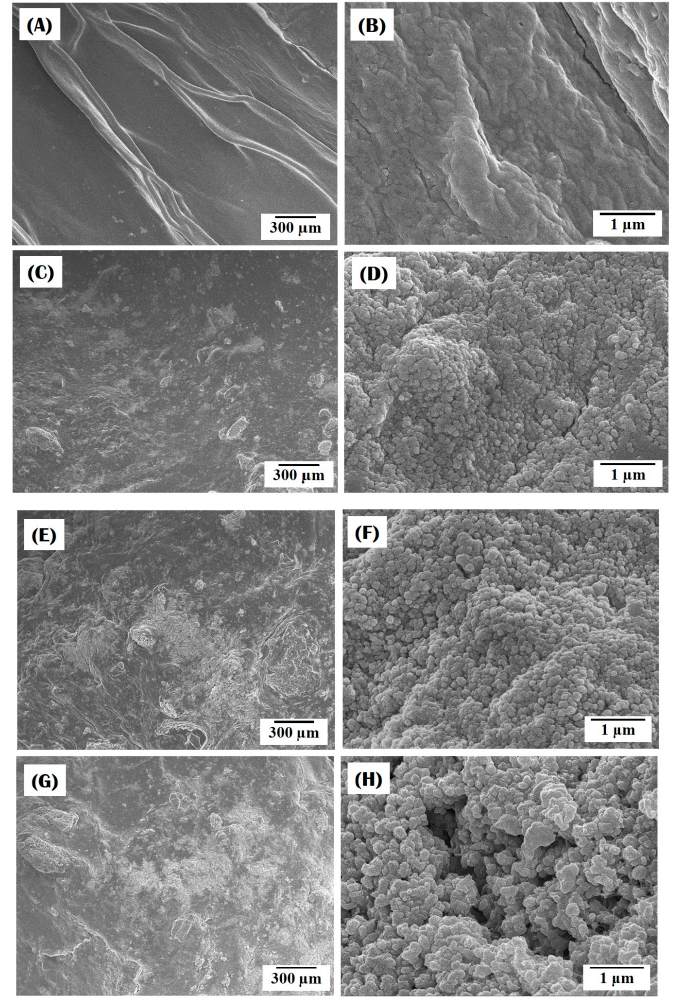
Figure 6. Representative FE-SEM images of nanofibrous collagen/HA composite microspheres synthesized with different levels of HA: ( A , B ) 0 wt %; ( C , D ) 10 wt %; ( E , F ) 15 wt %; ( G , H ) 20 wt %, after soaking in SBF solution for 3 days.